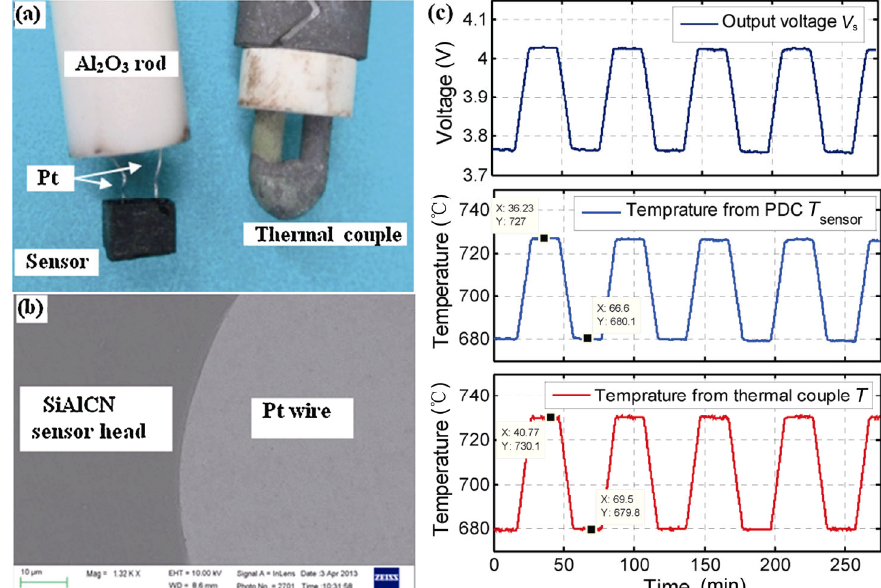
Fig. 15 (a) Photographs of a SiAlCN sensor with seamlessly embedded Pt leads (left) and a commercially available thermal couple used as reference (right); (b) SEM image showing the interface between SiAlCN and Pt leads; and (c) comparison between the temperatures measured by SiAlCN sensor and the commercial available thermal couple. Reproduced with permission from Ref. [366], © The Authors